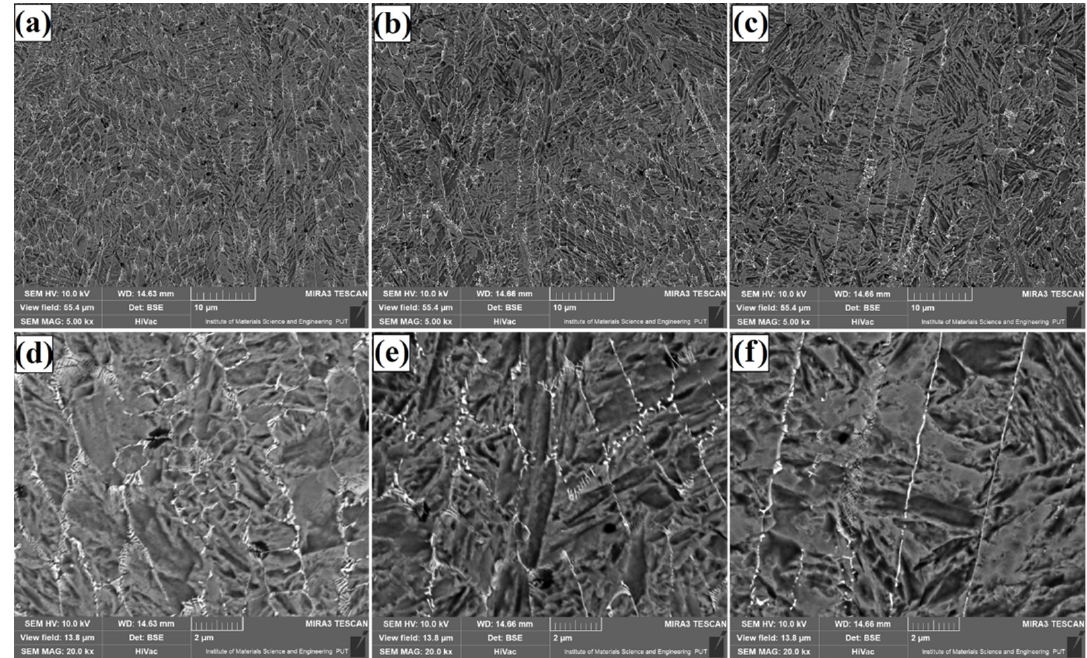
Figure 6. Near-substrate area of the Fe/TaC coatings produced on tool steel using 30 µm thick pre-coat and laser beam power of 500 W ( a , d ), 800 W ( b , e ), 1100 W ( c , f ).